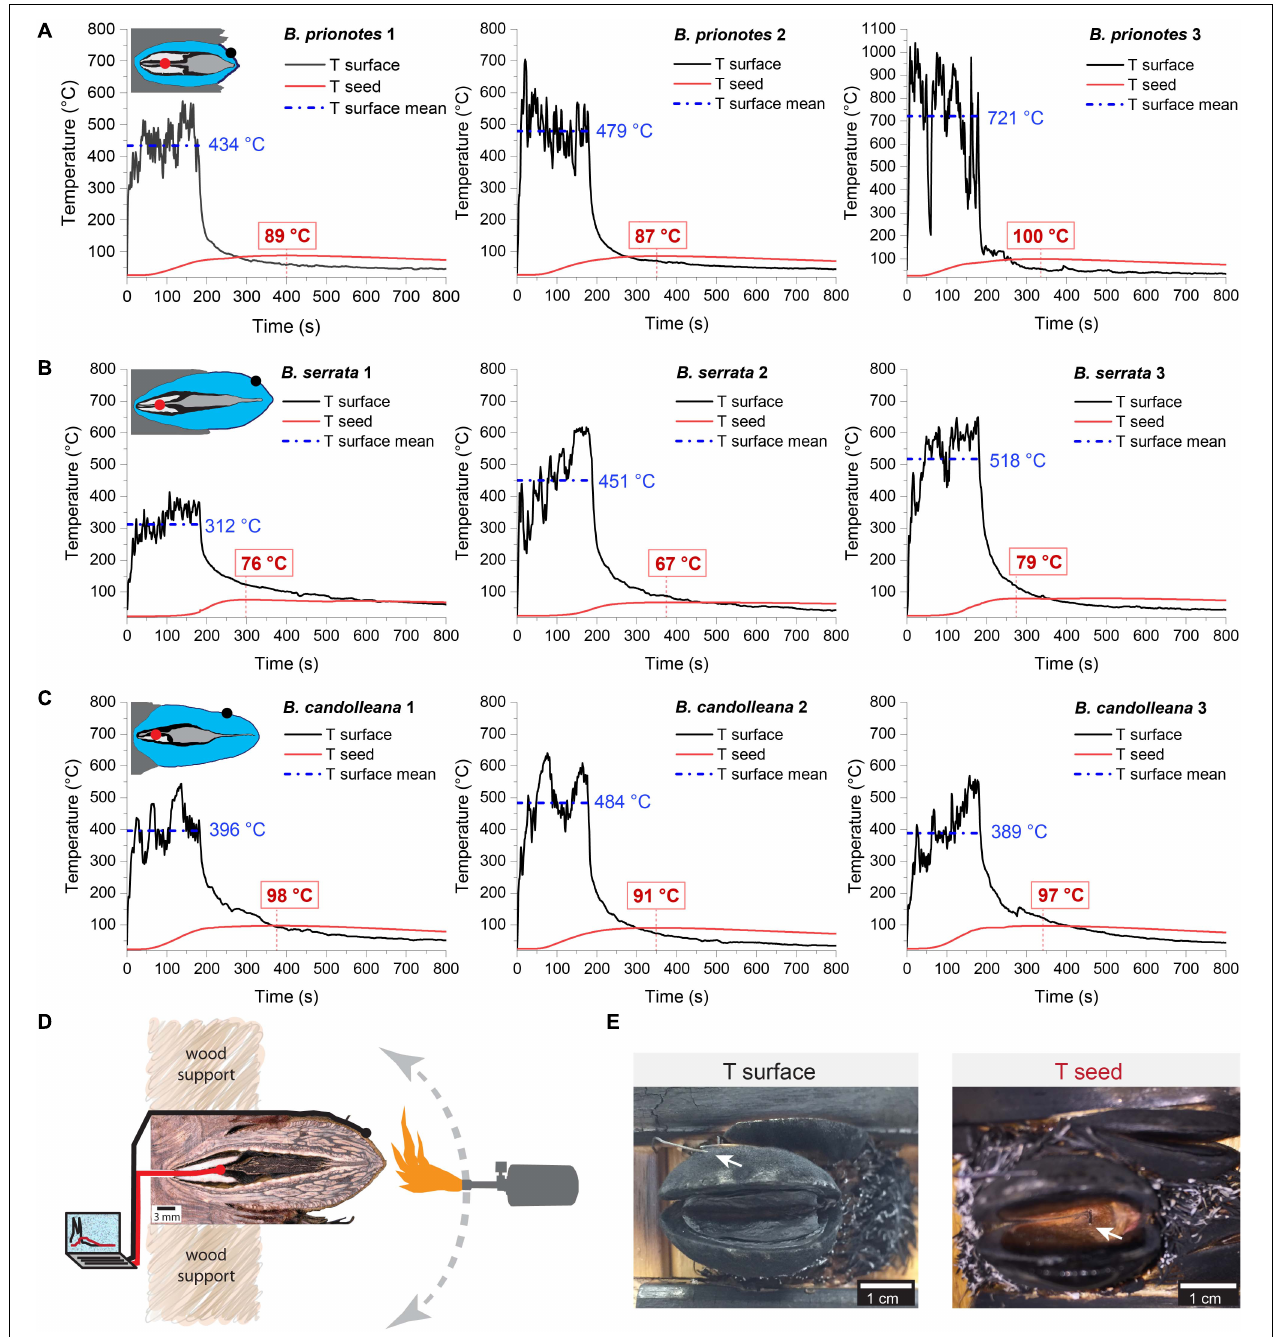
FIGURE 2 | Experimental burns (180 s) of follicles with different geometries. Temperatures were recorded on the surface of the upper valve (means during burning indicated in blue) and inside the follicle near the seed (maximum indicated in red) for three follicles of (A) B. serrata , (B) B. candolleana and (C) B. prionotes . Icons are schematic drawings based on longitudinal sections of follicles, dots show the approximate position of the two thermocouples ( T surface in black and T seed in red). (D) Experimental set-up for the 180 s burns: before burning, the mechanically isolated follicles were glued onto wood support holders at their embedment (the image shows a longitudinally sectioned follicle to illustrate the position of the thermocouples). The positions of the two thermocouples are indicated by the black and red ‘wires’. During burning, a Bunsen burner was manually rotated around the follicle for 180 s while recording the temperatures on the surface and near the seed(s). (E) Front views of follicles after burning. ( left ) the outer thermocouple was always positioned on the surface of the upper valve (arrow), measuring T surface . ( right ) The thermocouple near the seed, measuring T seed , was inserted through a small drill hole at the follicle base and is only visible after burning and removal of the separator and the seeds. Scratches on the seeds often confirmed that the thermocouple was placed centrally and directly on top of or below a seed.